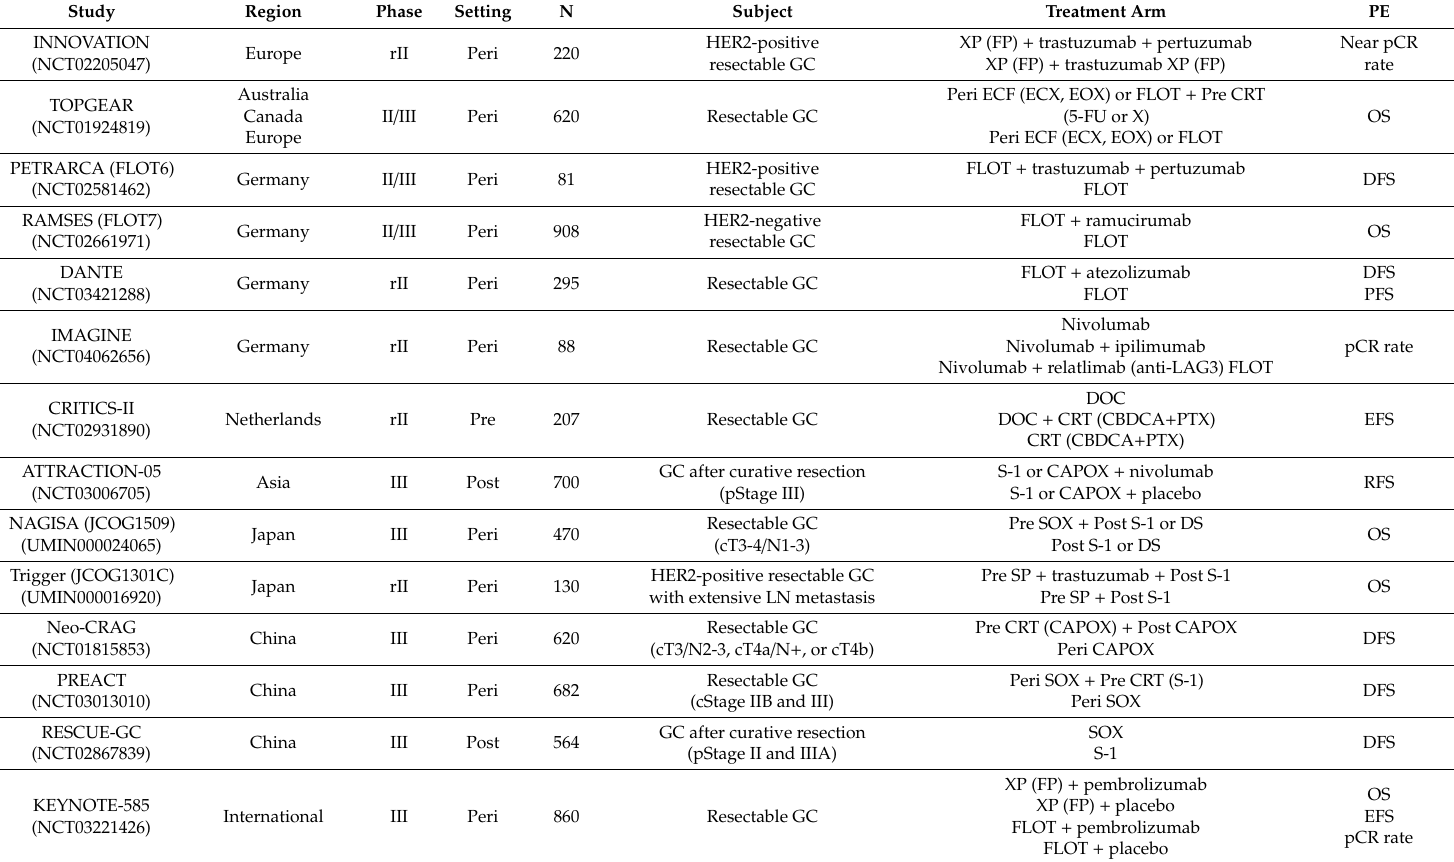
Table 2. Ongoing randomized phase II and III trials of adjuvant therapy in gastric